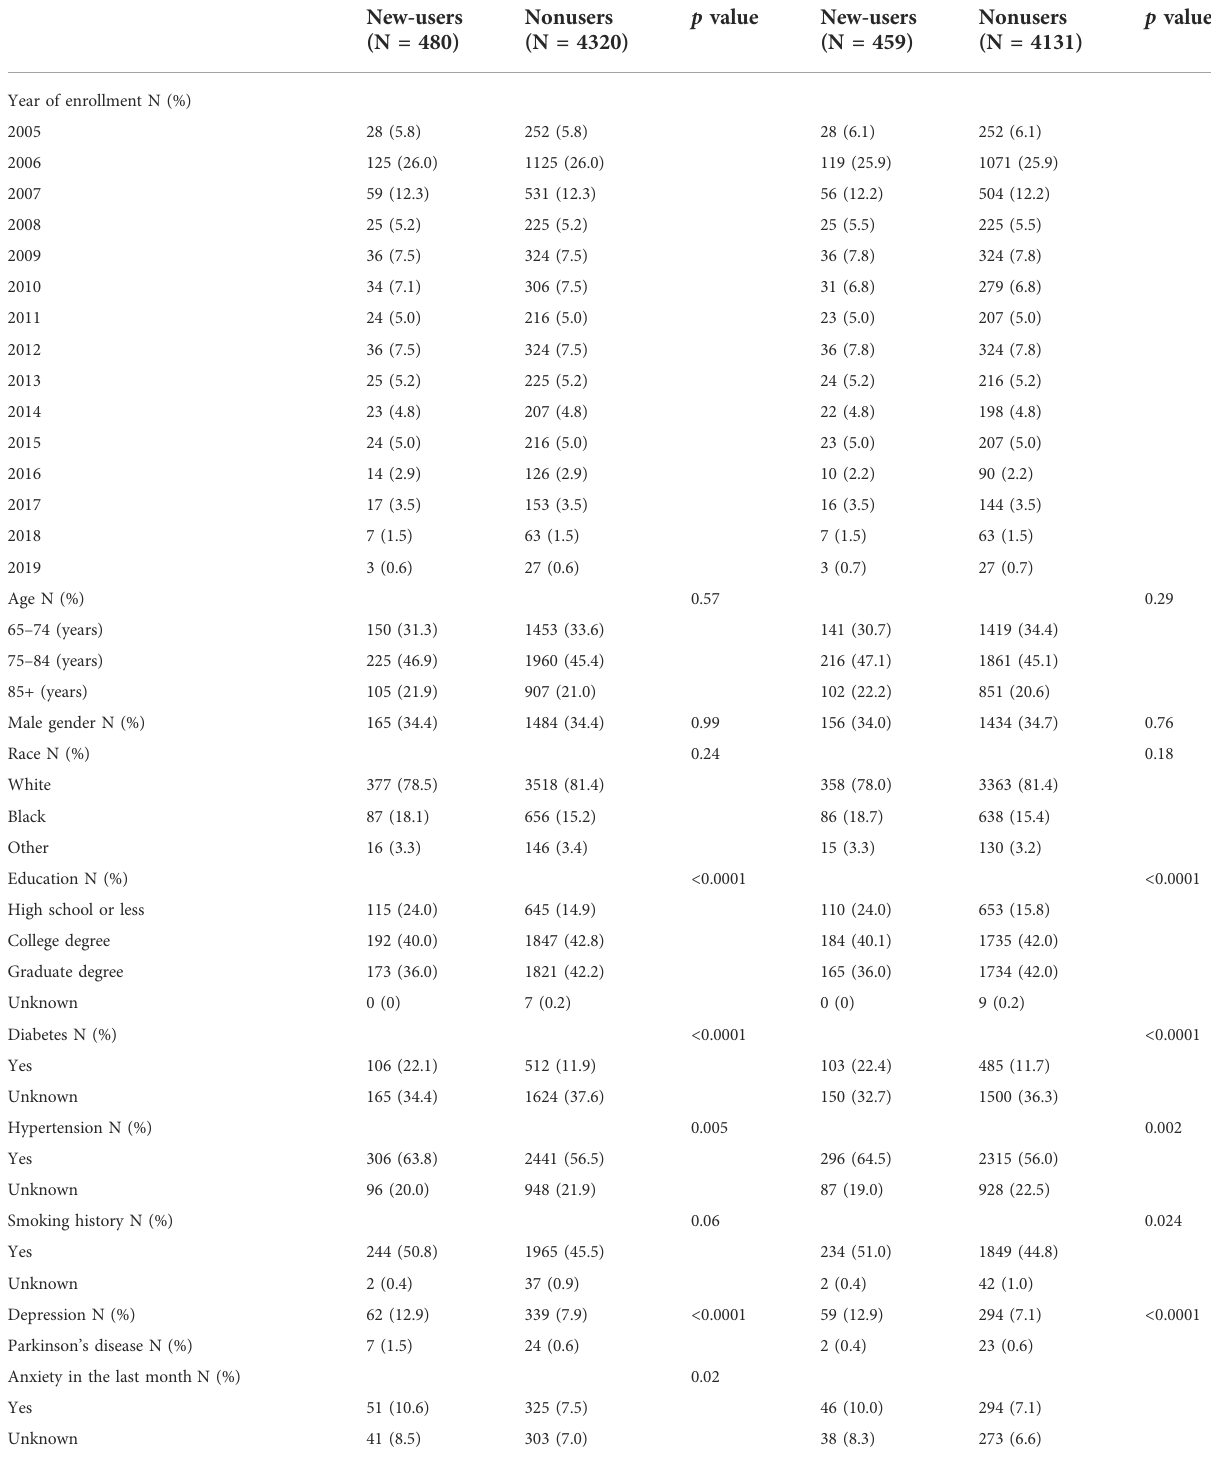
TABLE 1 Baseline characteristics in gabapentin new-users and